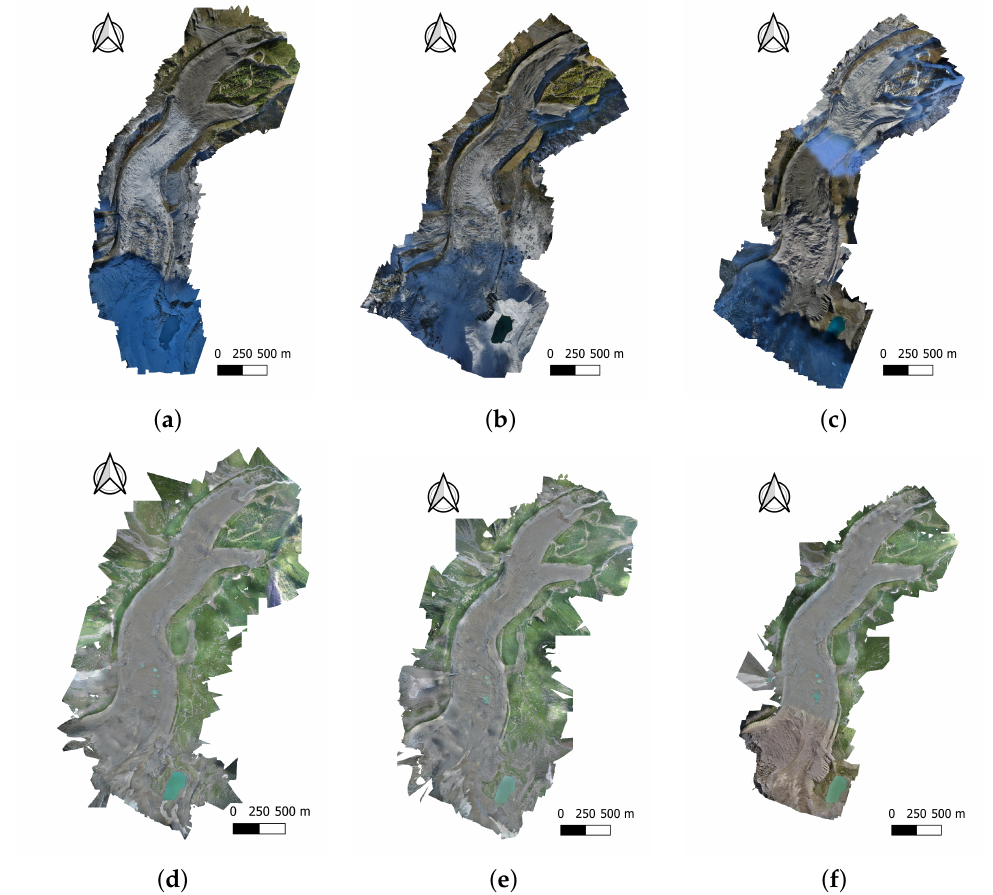
Figure 4. Orthophotos obtained from the photogrammetric model for each year: ( a ) 2015, ( b ) 2016, ( c ) 2017, ( d ) 2018, ( e ) 2019, ( f )